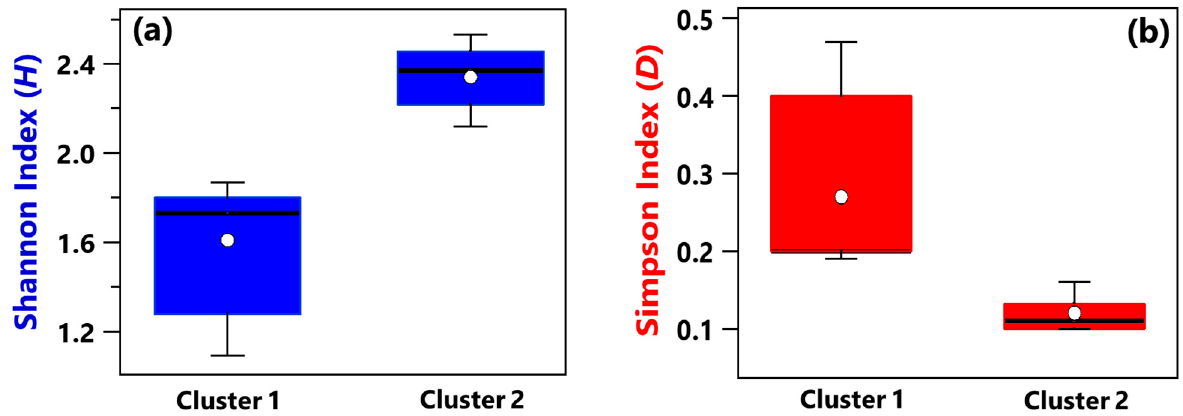
Figure 5. Boxplots displaying ( a ) Shannon and ( b ) Simpson indices calculated at the species level for samples belonging to Cluster 1 (B_R2, B_BAT, B_R1, DD1, A_R1, A_HR, HR1) and Cluster 2 (RO1, R3, HR2, DD2, RO2, R4, B+C1_R1, PSY, MED, B+C_R2). For each boxplot, the line within the box and the white dots represent the median and mean value, respectively. The bottom and top boundaries of each boxplot indicate the 25th and 75th percentiles, respectively. The whiskers are the 5th and 95th percentiles, respectively.